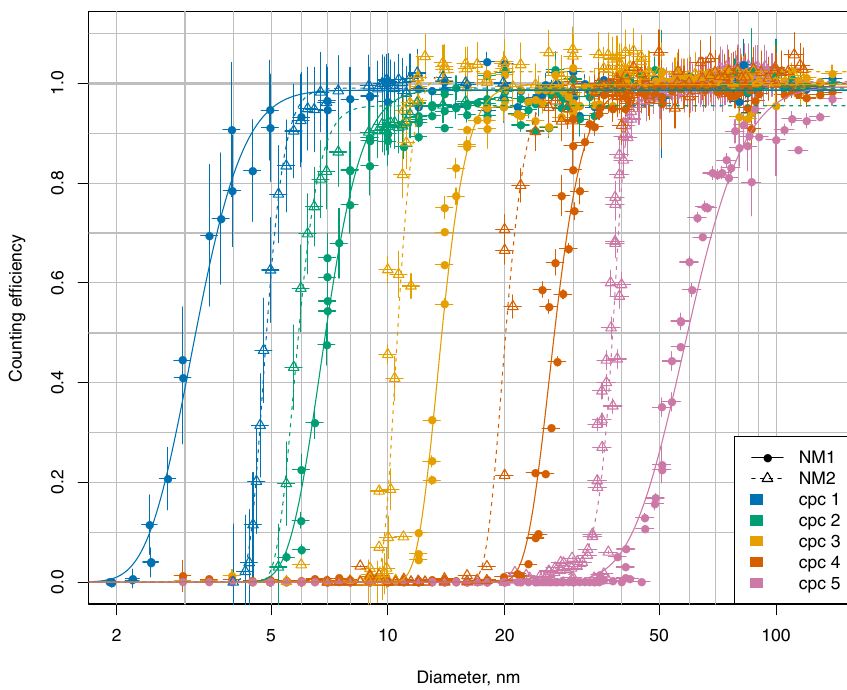
Figure 5. Counting efficiency of the two NMASSs in the settings used for the ATom mission (downstream pressure at 120hPa, saturator temperatures of both instruments are set to 39 ◦ C, condenser temperatures of NMASS 1 are 2.6, 16.2, 21.4, 26.2, and 29.7 ◦ C and condenser temperatures of NMASS 2 are 12.2, 13.6, 20.4, 27.2, and 30.7 ◦ C). The calibration (symbols) is done using particles generated by ozonolysis of limonene, and NMASS concentrations are compared to a TSI 3025 or 3776 CPC, with the CPC concentration corrected for its own counting efficiency at each diameter. Lines represent fitted logistic functions to guide the